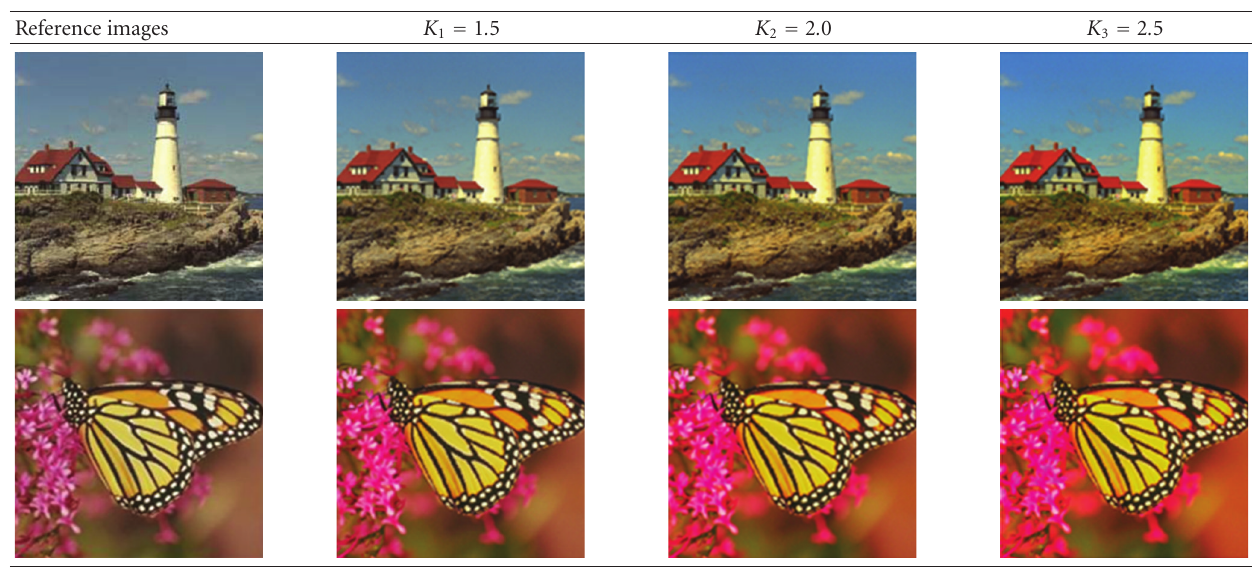
Table 2: Saturation test images